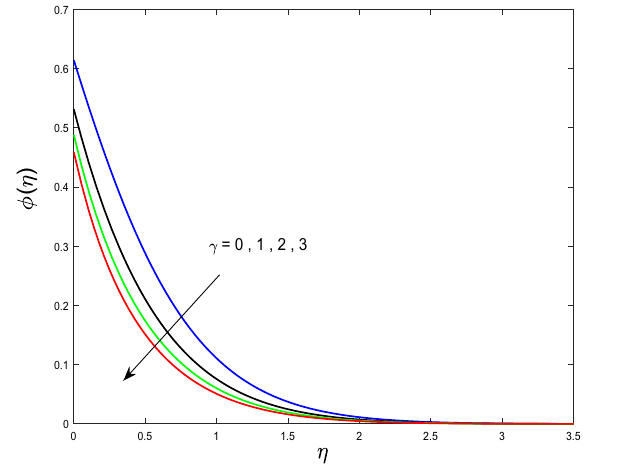
Figure 13. Plot of φ for γ .